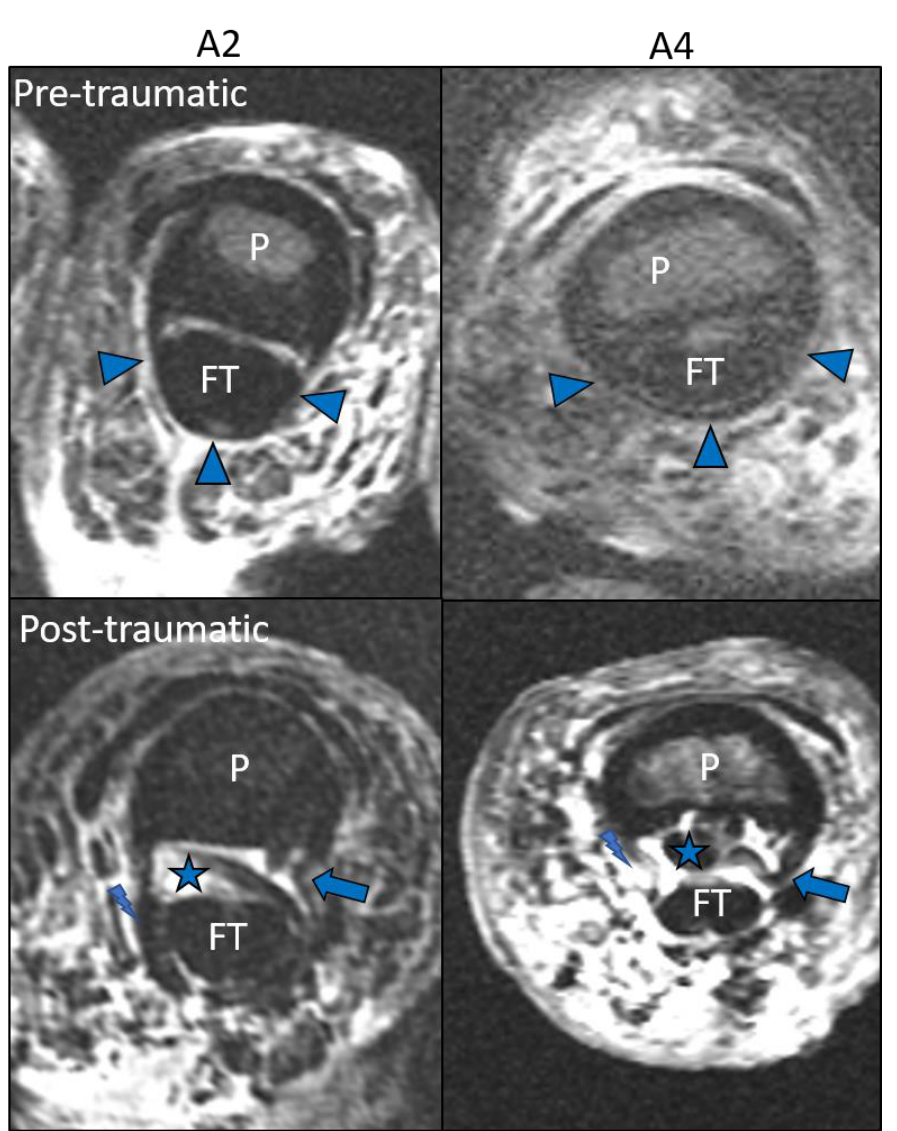
Figure 4. Characterization of pulley rupture with definition of intercalation as an injury complication. PD fs axial scans before ( above ) and after ( below ) iatrogenic pulley rupture creation. These A2 and A4 ruptures were characterized and confirmed as grade 2 (DISLOC.RUPT). Left A2, right A4 pulley. P = phalanx. FT = flexor tendon. Arrowhead = intact A2 and A4 pulley. Arrow = disrupted pulley stump. Asterisk = intercalation of disrupted pulley stump between FT and P. Lightning bolt = exact spot of rupture.